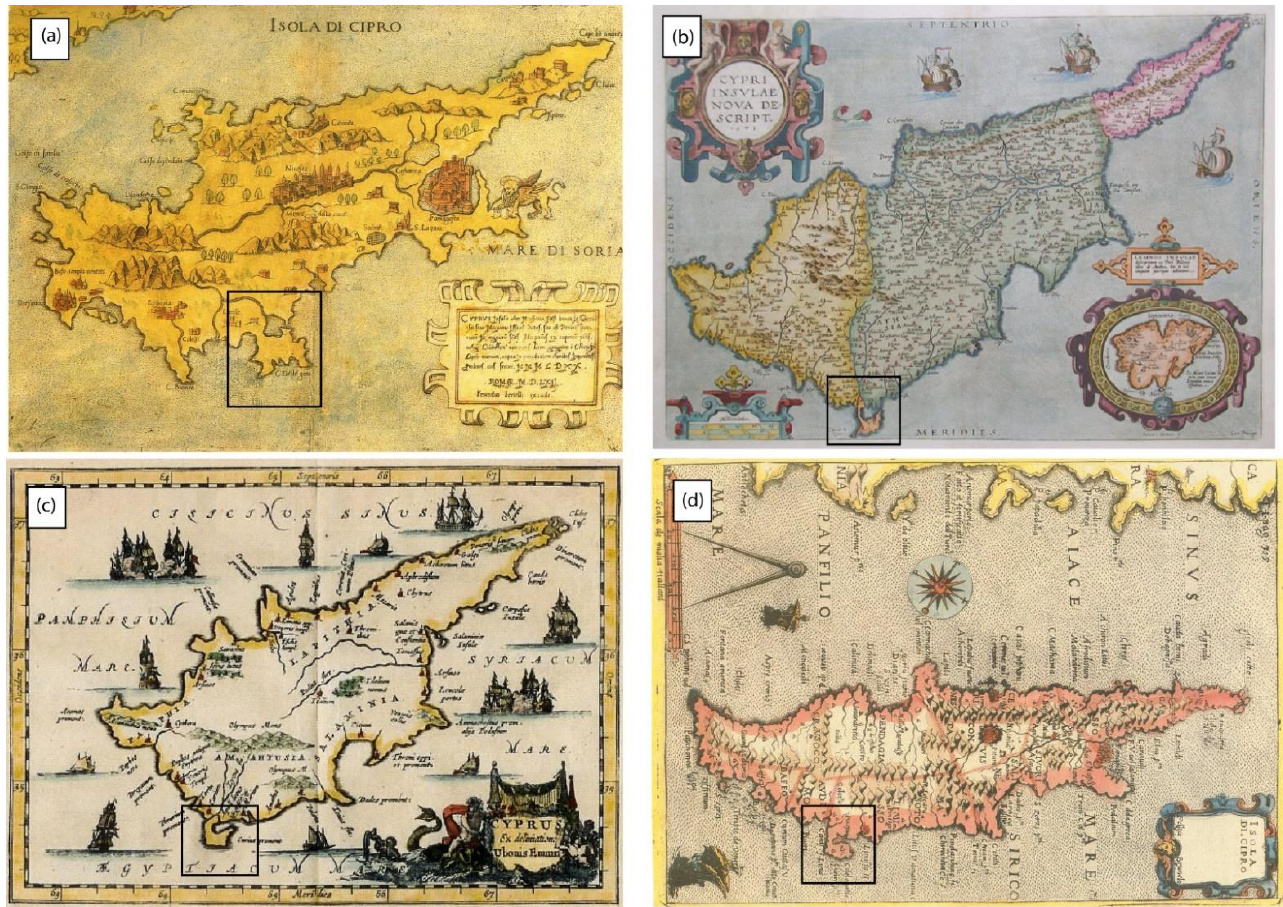
Figure 5. Historical maps of Cyprus. The study area is within the black square. ( a ) Ferrando Bertalli (1562), Isola Di Cipro. ( b ) Abraham Ortelius (1612) Cypri insulae nova descript. ( c ) Philipp Cluverius. (1682) Cyprus Ex deliniatione Ubonis Emmii. ( d ) Felice Brunello (1570) Isola di Cipro.